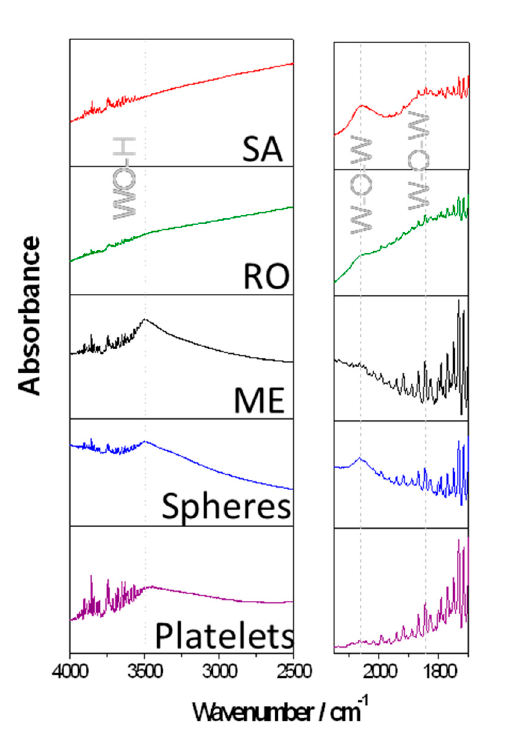
Figure 4. The operando DRIFT spectra of the WO 3 sensors during exposure to 10% RH. The spectra taken in humidity were referenced to those taken in dry